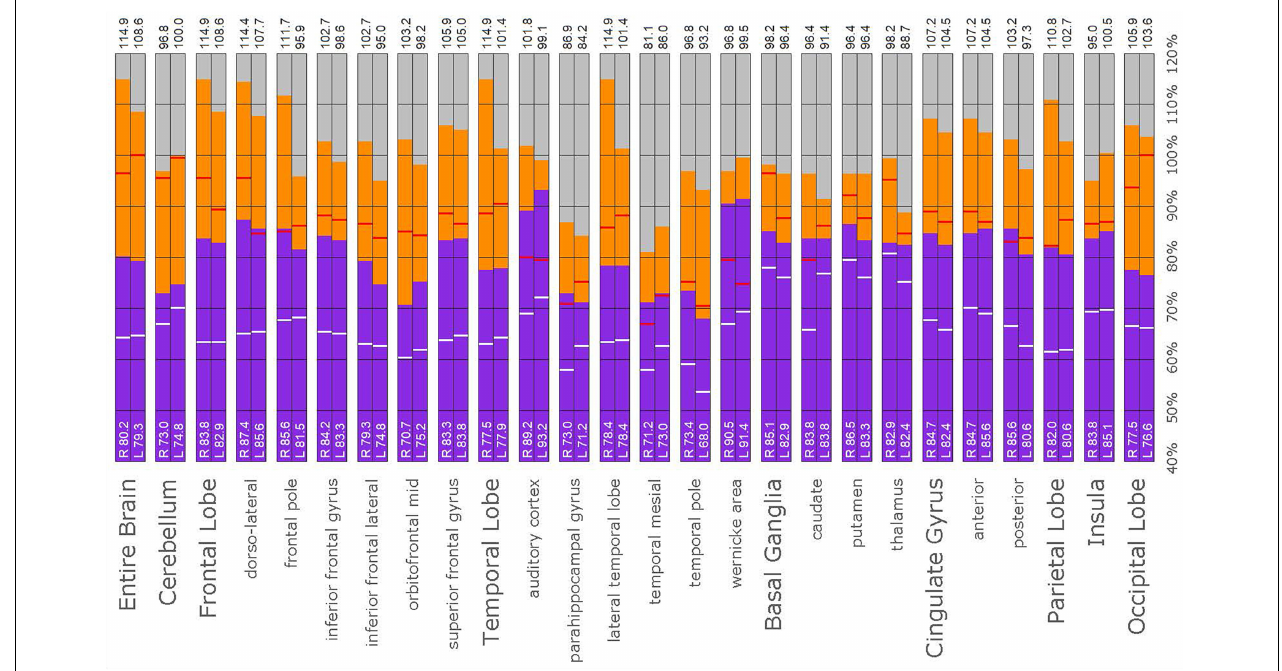
FIGURE 13 | Semi-quantitative region of interest analysis of the SPECT scan of Patient D. Data analysis and presentation is as described in Figure 10 . Thalamic perfusion exceeds the maximum in the cerebellum and is highly asymmetrical. The median and maximal counts in the thalamus exceed those of the normative sample. Multiple cortical areas of markedly increased perfusion are noted with marked asymmetry. In all ROI, with the exception of the cerebellum, the patient’s maximal counts exceed that of the normative sample (red line). In all ROIs, the patient’s median counts exceed that of the normative sample (white